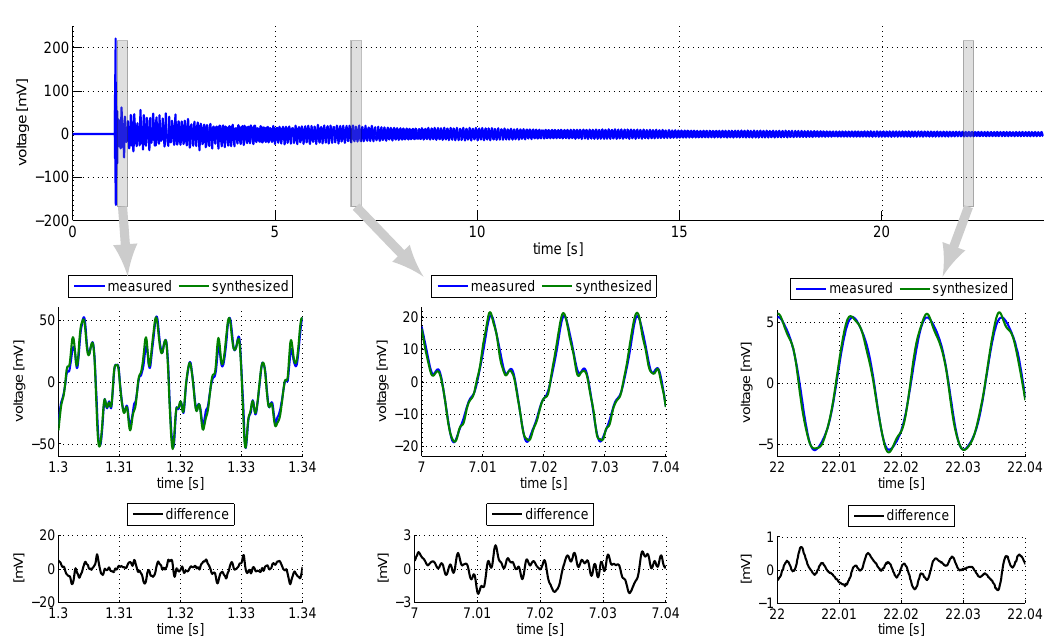
Figure 11. Recorded and synthesized signals of the voltage from the